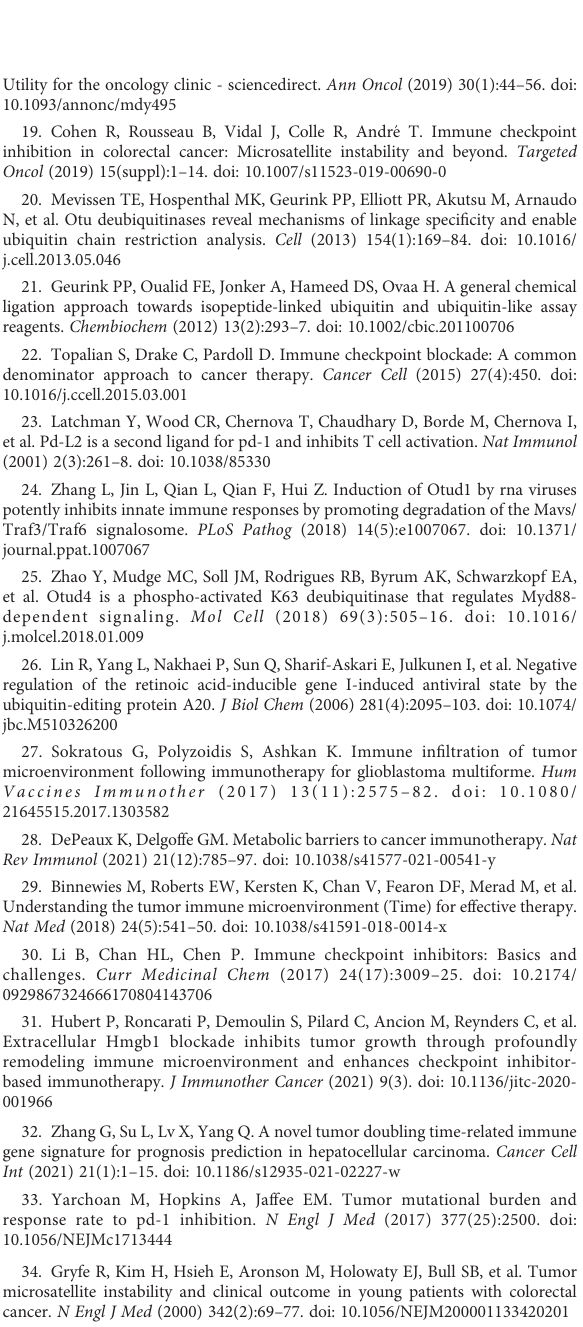
SUPPLEMENTARY FIGURE 3 (A) Correlation between OTUD6B expression and different immune cells using data from XCell database. (B) RNA modi fi cation and OTUD6B level in multiple tumor tissues. SUPPLEMENTARY FIGURE 4 Association of OTUD6B expression level with Stromal Score across different types of